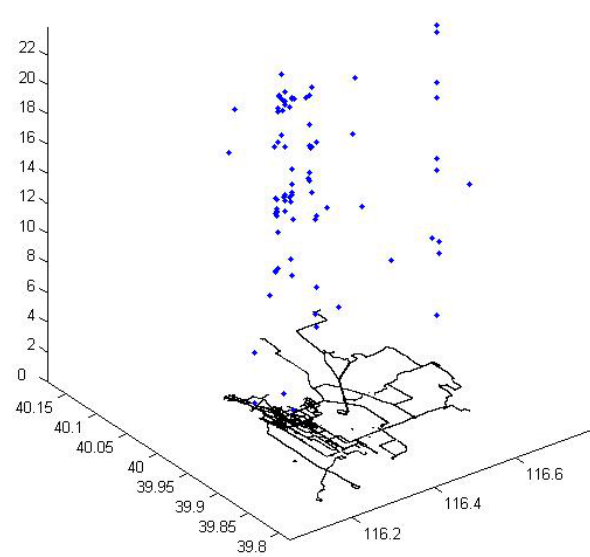
Figure 5. clustered hotspots of multipeople